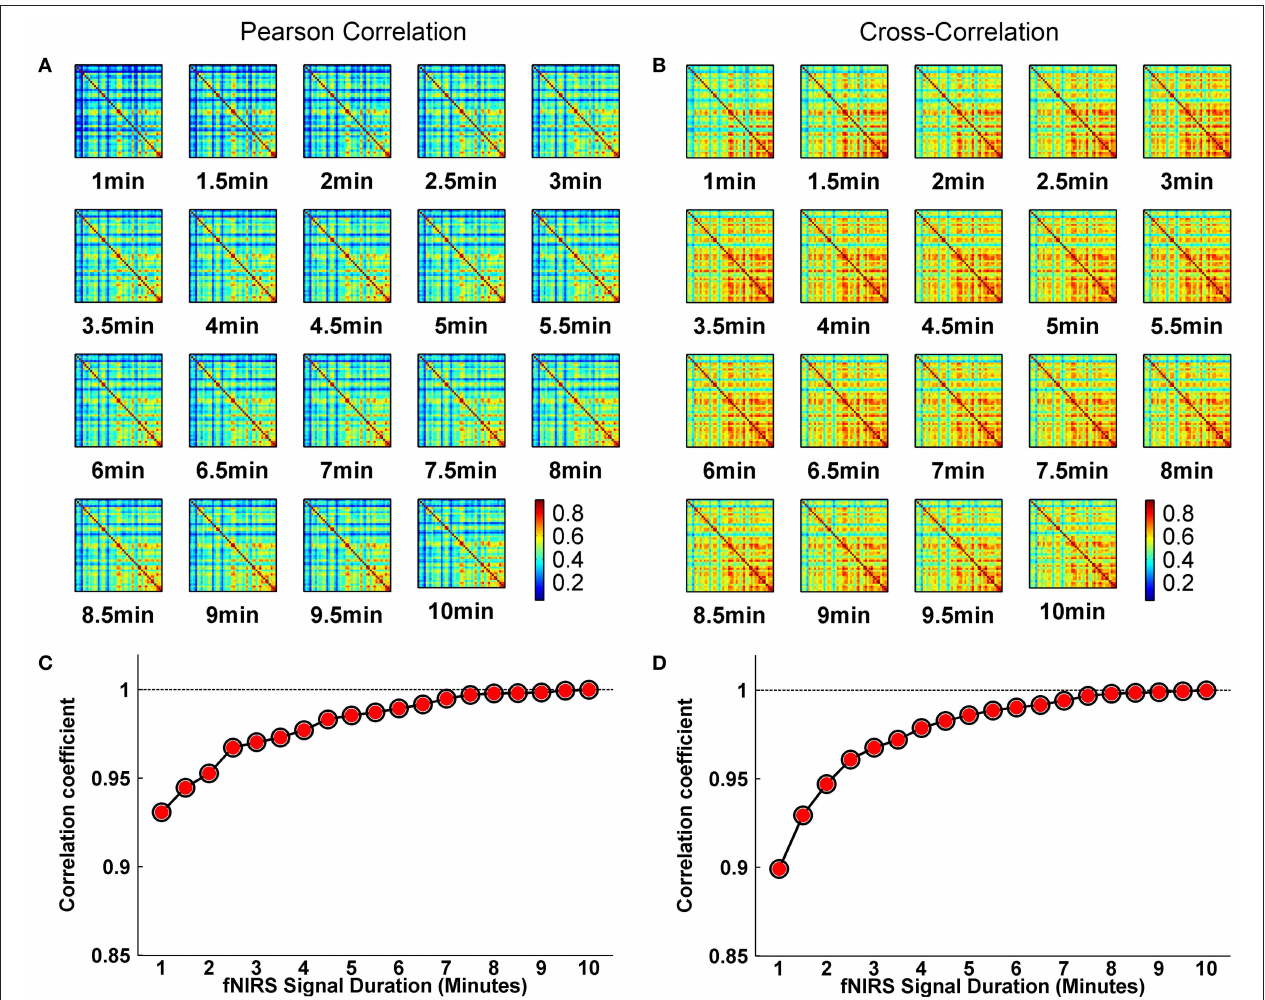
FIGURE 2 | Effect of fNIRS signal acquisition duration on the stability of the spatial FC map. (A,B) Graphs show FC patterns plotted vs. the duration of fNIRS signal duration (1.0–10.0 min in 30s bins). (C,D) Between-map correlation coefficients calculated for spatial pattern of FC between short and long (up to 10-min) signal durations. The red-filled circles indicate significant correlation between the 10-min signal duration based spatial FC pattern and spatial FC pattern derived from each fNIRS signal acquisition duration from 1 to 10 min with a 30-s increment. The FC in (A,C) and (B,D) calculated from Pearson correlation-derived and cross- correlation-derived networks,